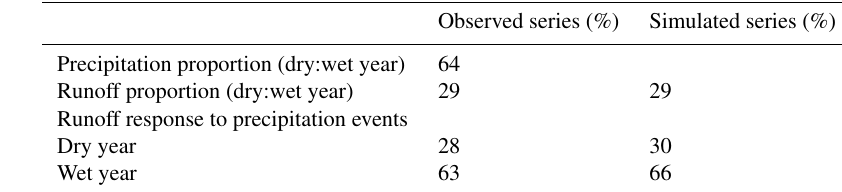
Table 4. Quantification of runoff and precipitation dynamics in wet and dry years using the observed series and simulated series from PERSiST.